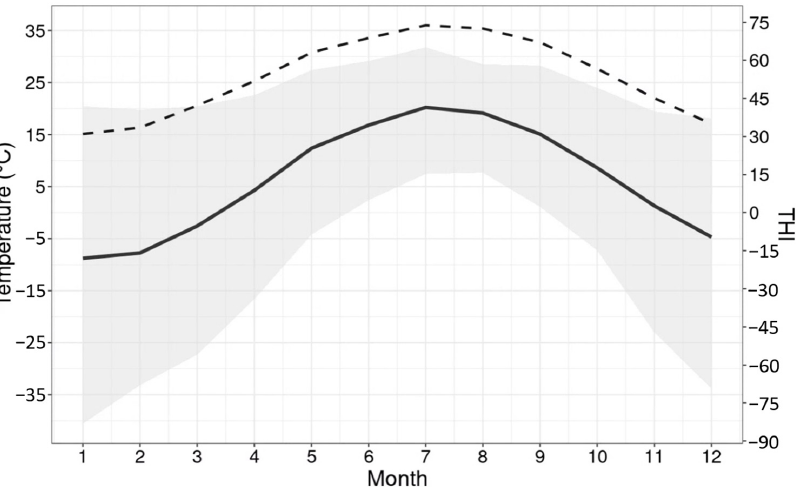
Figure 1. Distribution of mean ambient temperature (solid line) and its variation (shaded area) and mean temperature-humidity index (THI; dashed line) per month from January 2010 to December 2020. Table 1. Mean and standard deviation (SD) of test-day records for milk production traits below and above the temperature-humidity index (THI) threshold for milk, fat and protein